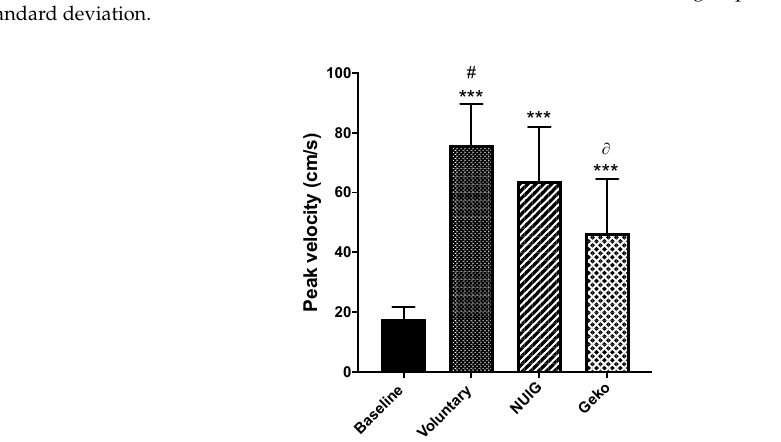
Figure 2. The e ff ect of the intervention on the peak venous velocity (cm / s). The peak velocity showed a significant increase in all voluntary ( n = 24), Geko ( n = 9), and NUIG device ( n = 12) interventions in comparison to baseline ( n = 24) (*** p < 0.0001 versus. baseline; # p < 0.0001 versus. Geko; ∂ p < 0.05 versus. NUIG). Data shown as ± SD. Table 1. Summary of results from all interventions and parameters measured. P Versus. P Versus. Baseline Baseline